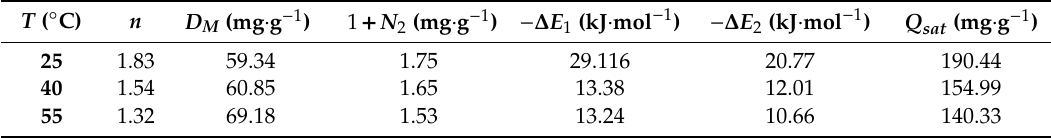
Figure 5. Evolution of n ( a ), D M ( b ), Q sat ( c ), ∆ E ( d ) parameters as a function of temperature and the possible adsorption mechanism for MO on Mn-mica ( e ). Table 6. Steric and energetic parameters of the multilayer layer model for the adsorption of MO on adsorbent